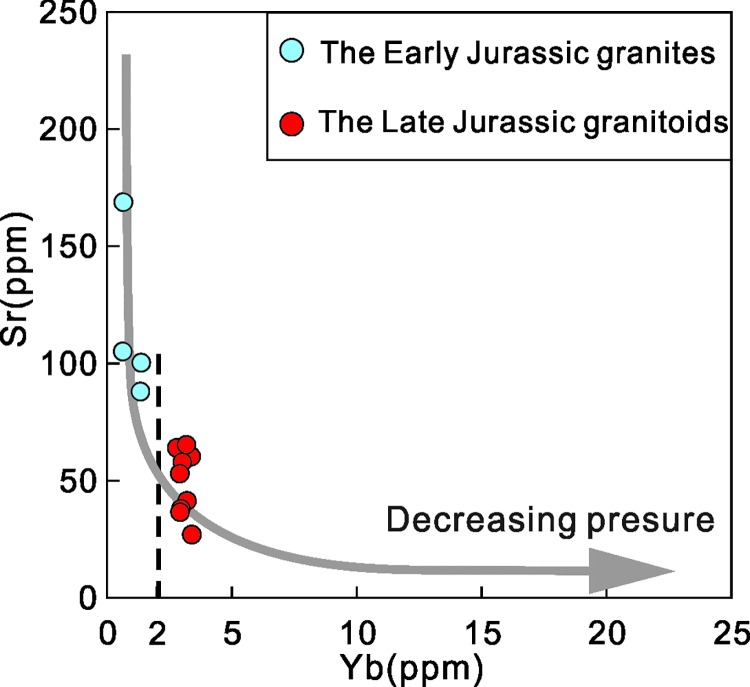
Sr vs Yb diagram for Jurassic granitic rocks in NIC[71].